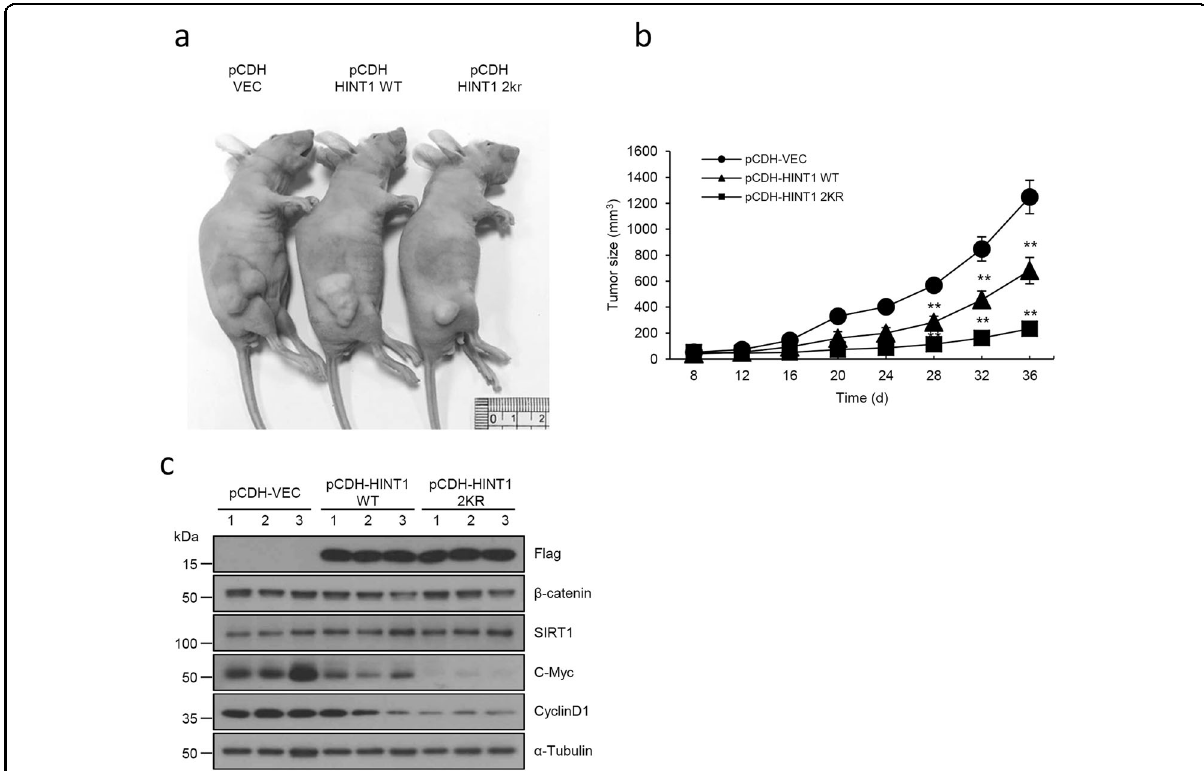
Fig. 6 The deacetylated HINT1 mutant (HINT1 2KR) suppresses tumorigenesis in an in vivo xenograft mouse model. Nude mice ( fi ve mice/ group) were injected with 1 × 10 7 DLD1 cells stably transfected with mock control or with the Flag-HINT1 WT or 2KR construct. The xenograft tumors were measured at the indicated times and dissected at the endpoint. a Representative images of mice are shown. Scale bar: 1 cm. b Quanti fi cation of the average volume of tumors as indicated times is shown. The data show the mean ± SEM versus negative control pCDH-VEC. ** P < 0.01. c Protein levels of cyclin D1 and c-Myc were determined by western blot assay in tumors derived from three nude mice from each